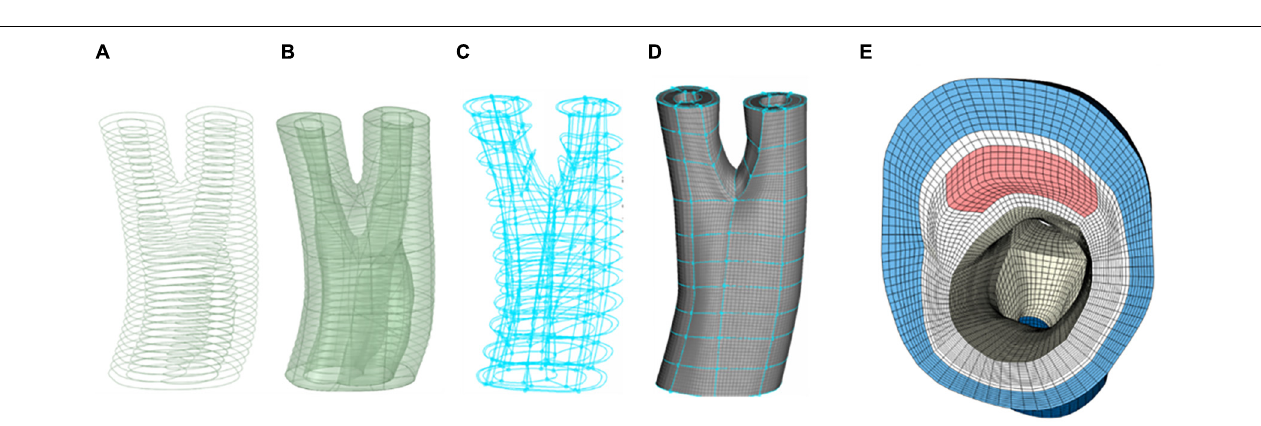
FIGURE 2 | The Sequence of generating a structured hexahedral mesh from a human carotid bifurcation. (A) The STL mesh and definition of the boxes indicating the common, internal and external carotid artery. (B) Associating the boxes to the outermost surface of the STL mesh. (C) Using the O-Grid function to define the luminal surface. (D) Final meshed geometry.